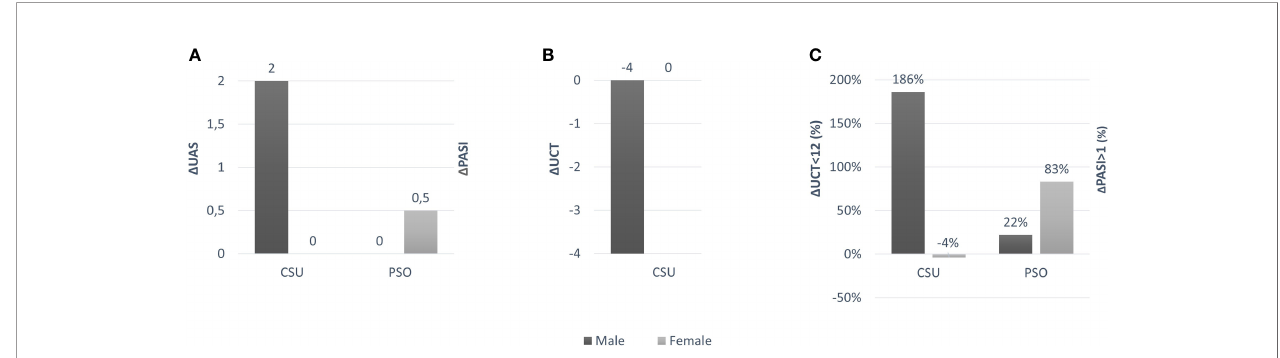
FIGURE 1 | (A) Difference in UAS and PASI values for female and male patients between 2019 and 2020; (B) Difference in UCT value for female and male patients between 2019 and 2020; (C) Difference in% between UCT <12 and PASI> 1 values in female and male patients between 2019 and